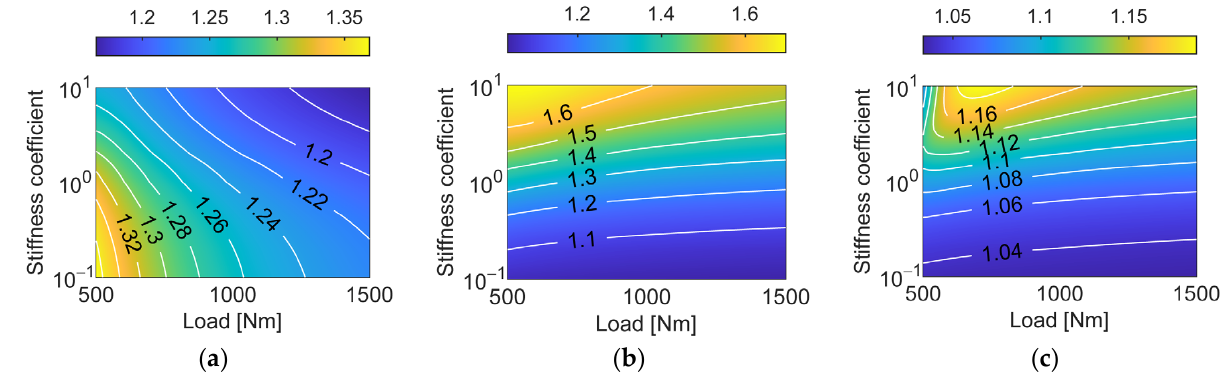
Figure 15. Influence of support stiffness of Input Gear 2 on load-sharing coefficient: ( a ) Input Gear 1; ( b ) Input Gear 2; ( c ) idler gear.